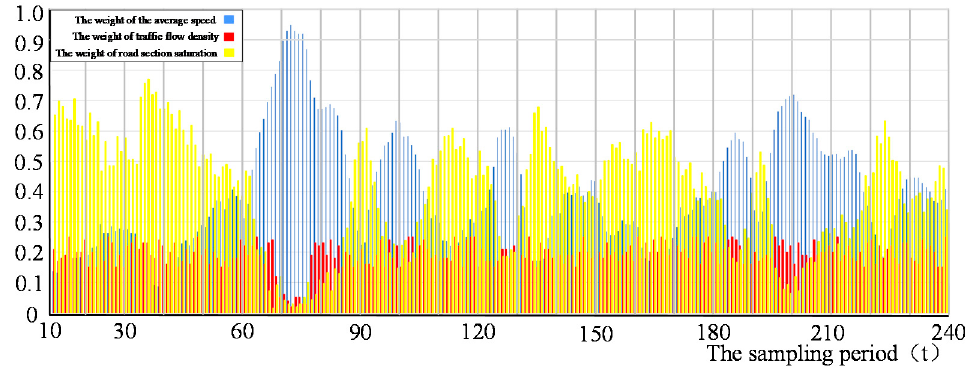
Figure 13. Weight of the traffic congestion evaluation index.